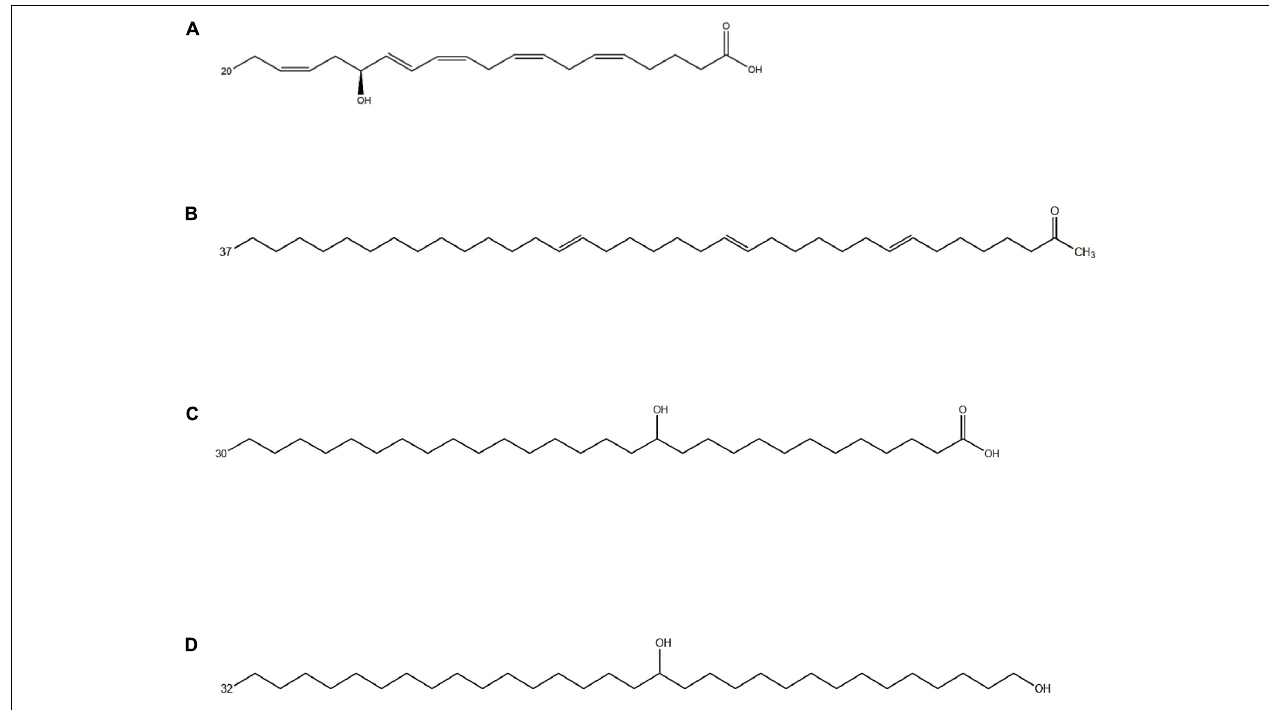
FIGURE 2 | Chemical structure of different fatty acid derivatives of microalgal origin: (A) 15-OH-C 20 : 5 ω 3 (15-HEPE), an oxylipin from Nannochloropsis gaditana resulting from EPA oxidation (de los Reyes et al., 2014); (B) C 37 : 3 methyl alkenones from Emiliania huxleyi (Volkman et al., 1980); (C) 13-OH-C 30 : 0 and (D) C 32 : 0 1,15 diol from Nannochloropsis spp., likely resulting from a PKS-catalyzed incomplete fatty acid elongation (Balzano et al.,